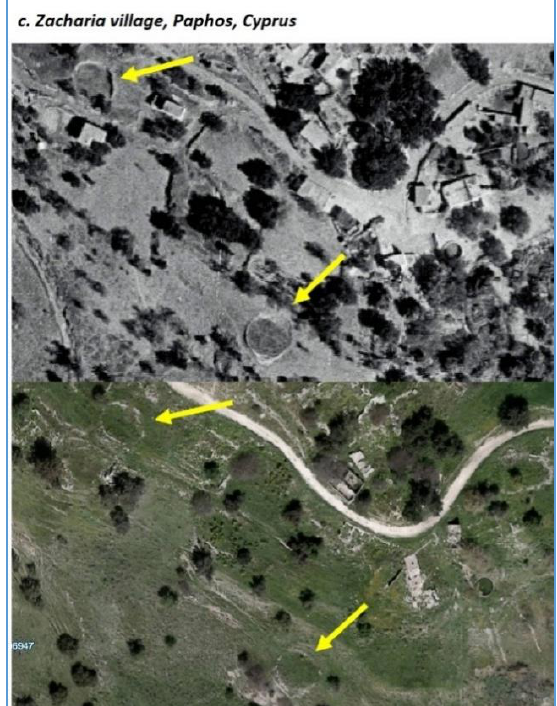
Figure 8. Threshing floors detected in Zacharia vilalge in